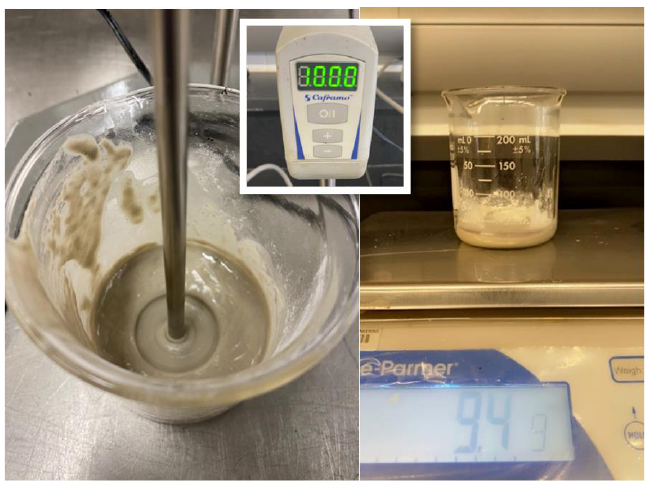
Figure 5. Mixing procedure of GPCM .